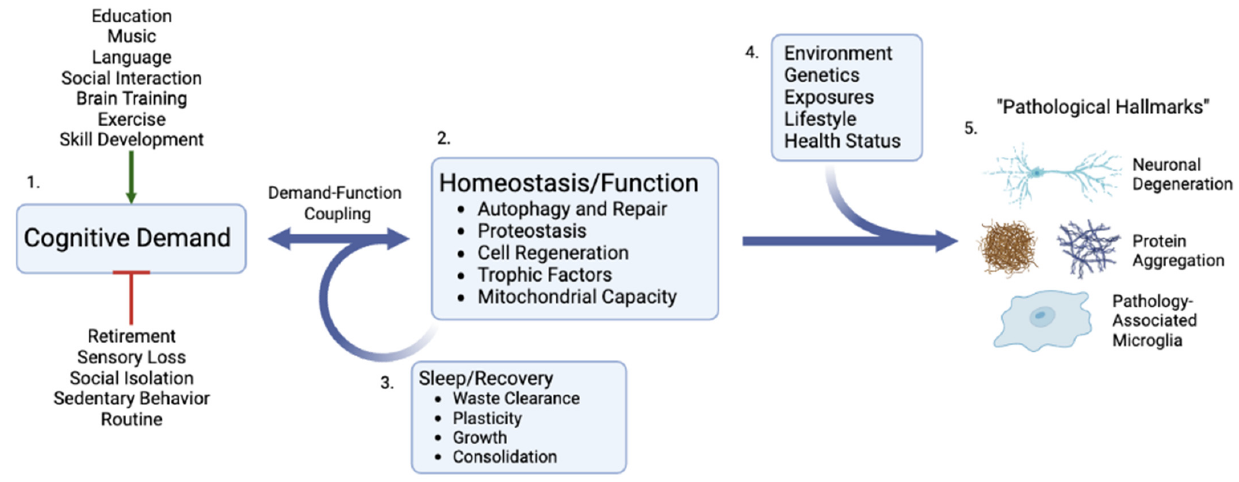
Figure 2. Cognitive demand as the critical upstream determinant of cognitive function and de- cline. 1. Cognitive demand is increased or decreased as a result of numerous individual and societal factors that can either positively or negatively affect the entire cascade. 2. As a result of direct demand-function coupling, cellular and organ responses down/upregulate homeostatic processes that can either increase or decrease repair, autophagy, and function. 3. Critical demand–function responses such as waste clearance and plasticity occur during recovery periods, particularly sleep. 4. In the setting of low demand and/or inadequate recovery, an individual’s personal environmental, health, and genetic circumstances result in differing and heterogeneous pathological phenotypes and cellular hallmarks of dementia and cognitive decline. 5. Created with BioRender.com.